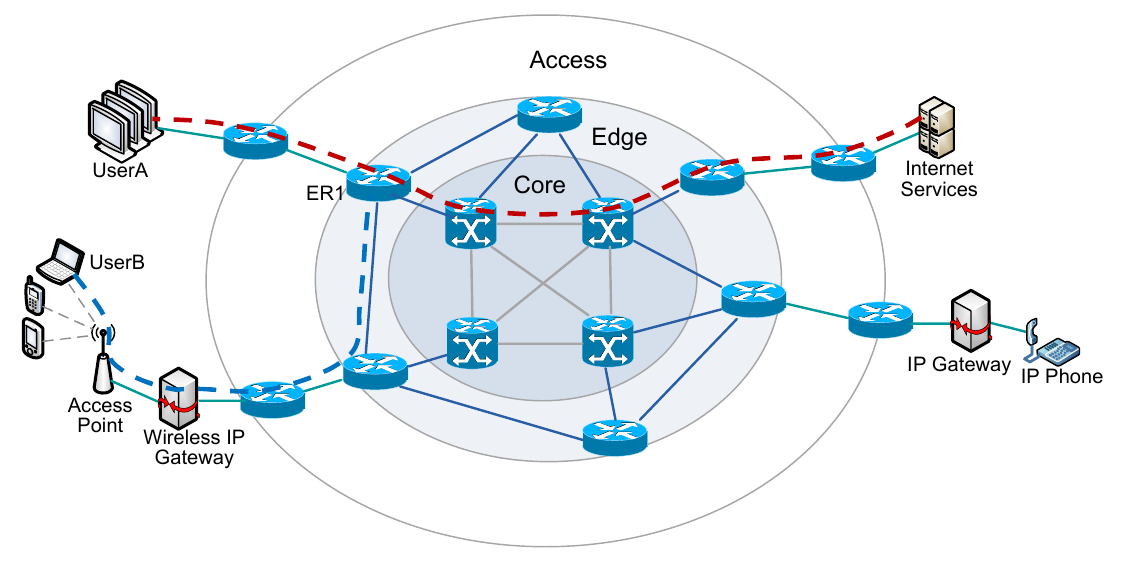
Figure 1. Generic architecture of the present